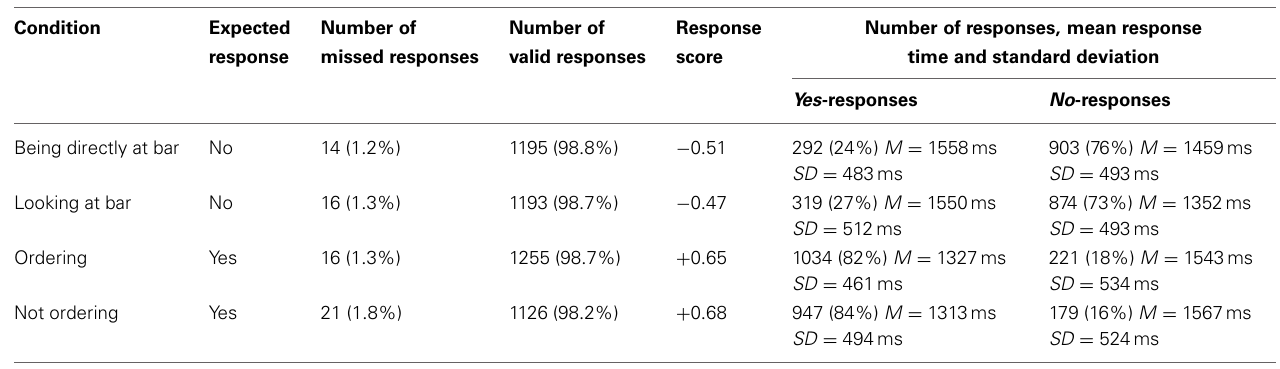
Table 2 | Results of Experiment